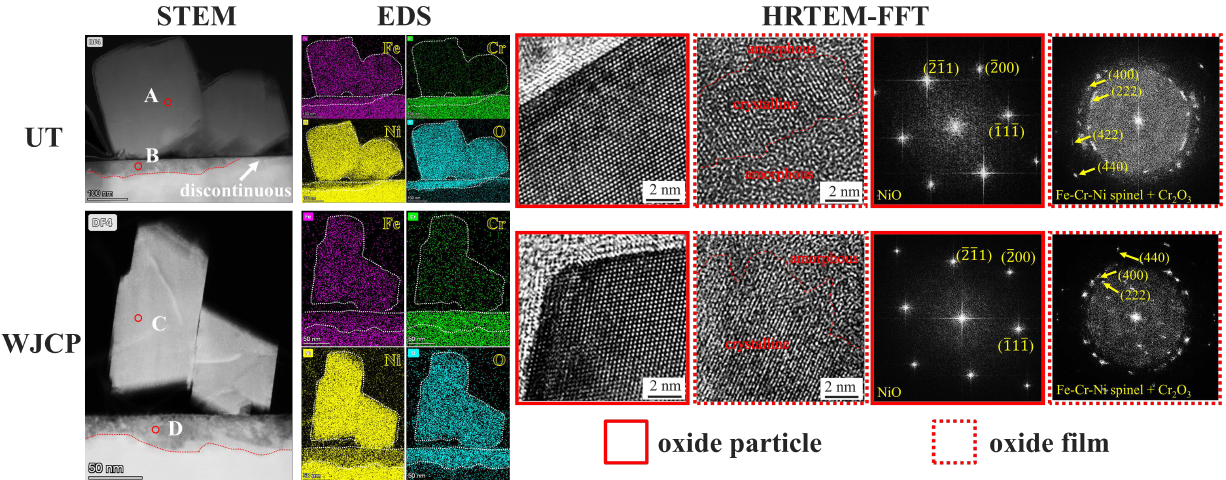
Figure 3. STEM-EDS and HRTEM-FFT of oxide scale formed on the surface of UT and WJCP-treated 600 MA.